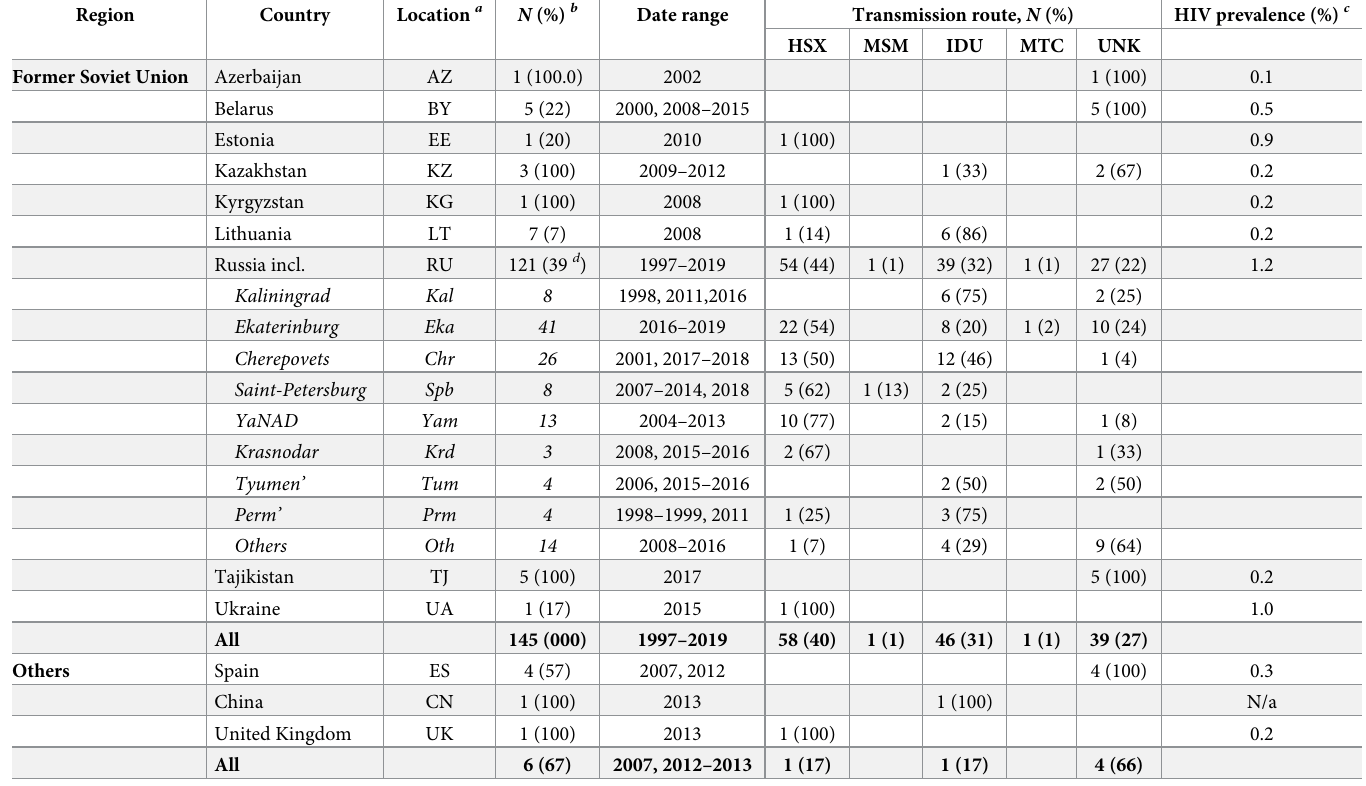
a Location assigned in the phylo(-geographic)genetic analysis.